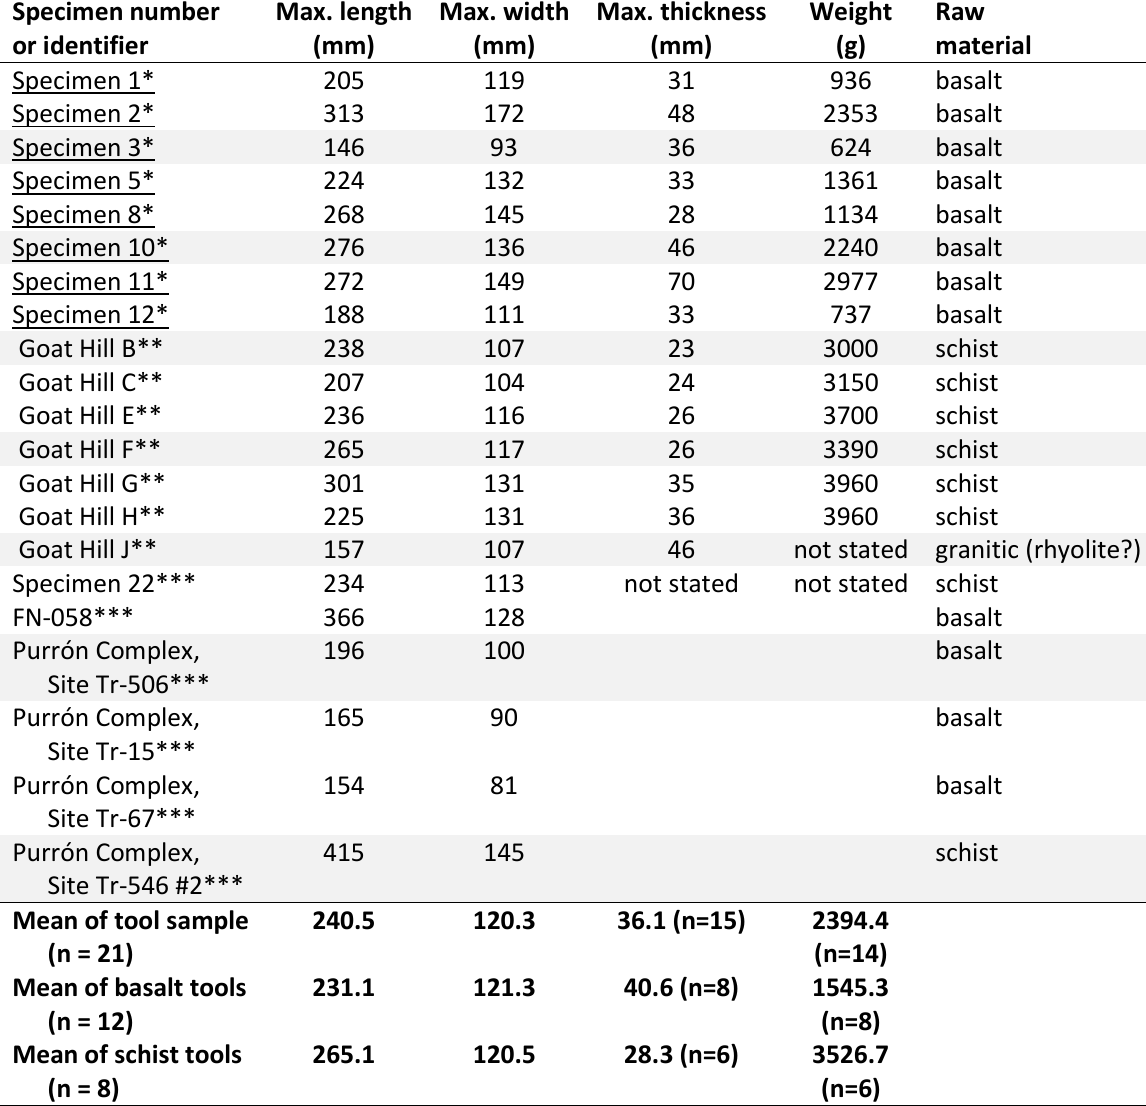
Table 2. Metric Characteristics of Sub-Rectangular-shaped tools (n=21). Specimen numbers having one asterisk were subject to detailed metric analyses. Specimen numbers with two asterisks represent artifacts from Woodson’s (1995, 1999) excavation. Specimen numbers with three asterisks represent tools documented in the field or gleaned from the